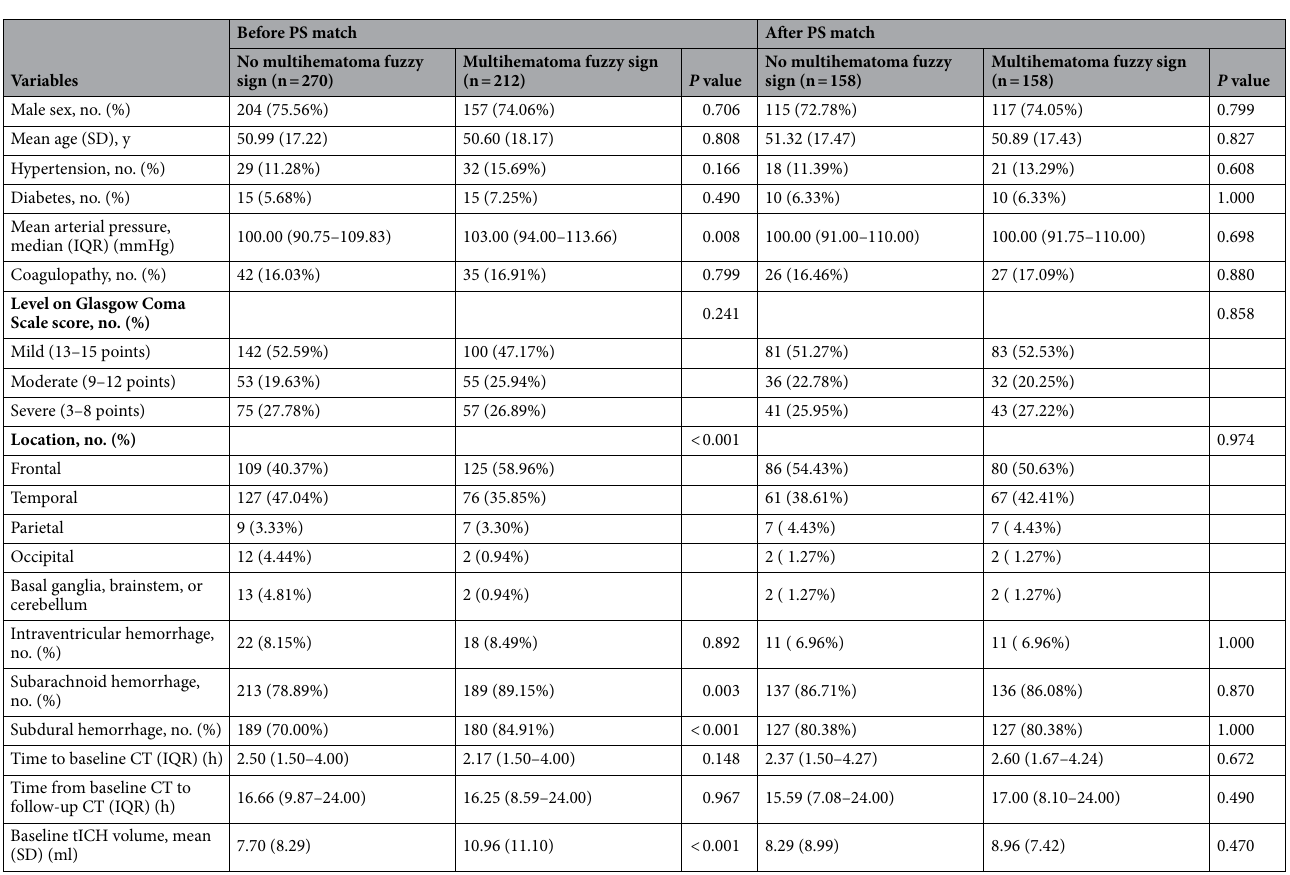
Table 1. Baseline characteristics of patients with or without multihematoma fuzzy sign before and after propensity score (PS)